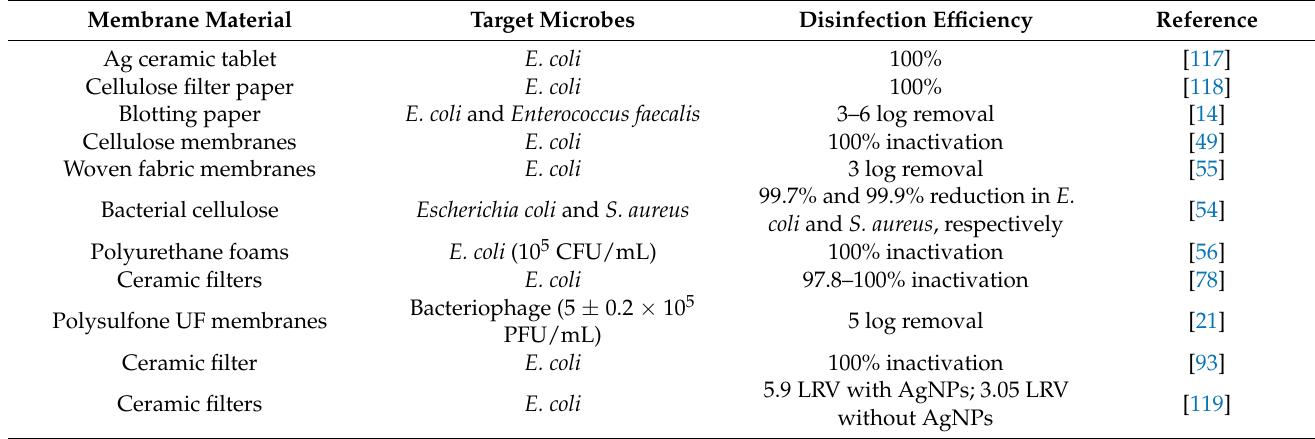
Table 3. Performance of AgNP-impregnated membranes in inactivation of